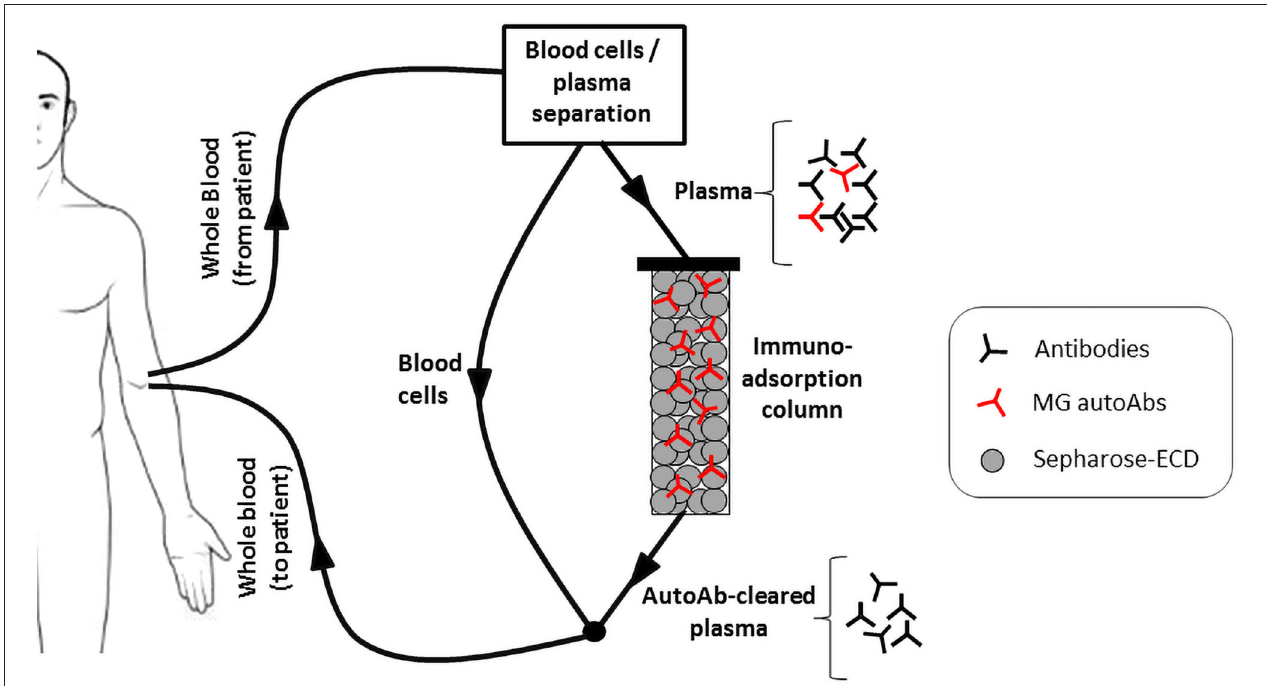
FIGURE 2 | The antigen specific immunoadsorption therapy approach. Recombinant extracellular domains (ECDs) of the AChR or MuSK are immobilized onto sepharose and packed into a column. During treatment, the patient’s plasma is passed through it, allowing the selective binding and removal of only the MG autoantibodies. The autoantibody-depleted plasma is then returned to the